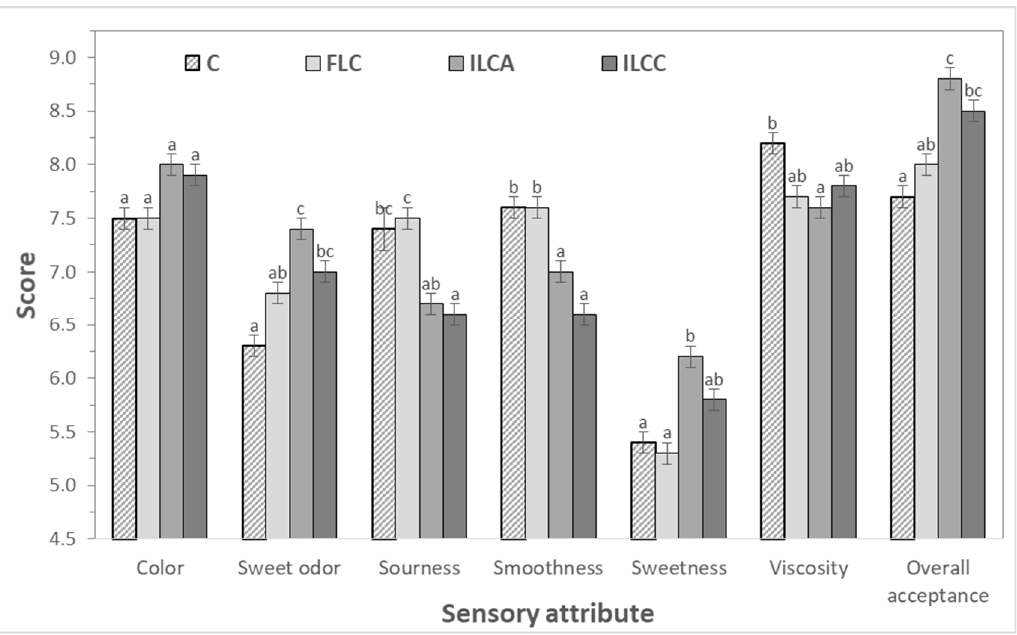
Figure 4. Sensory evaluation of novel probiotic yogurts produced using free (FLC) or immobilized L. casei ATCC 393 cells on apple pieces (ILCA) and casein (ILCC) in comparison to control samples (C). Different letters in the columns in the same sensory attribute indicate significant differences ( p < 0.05).